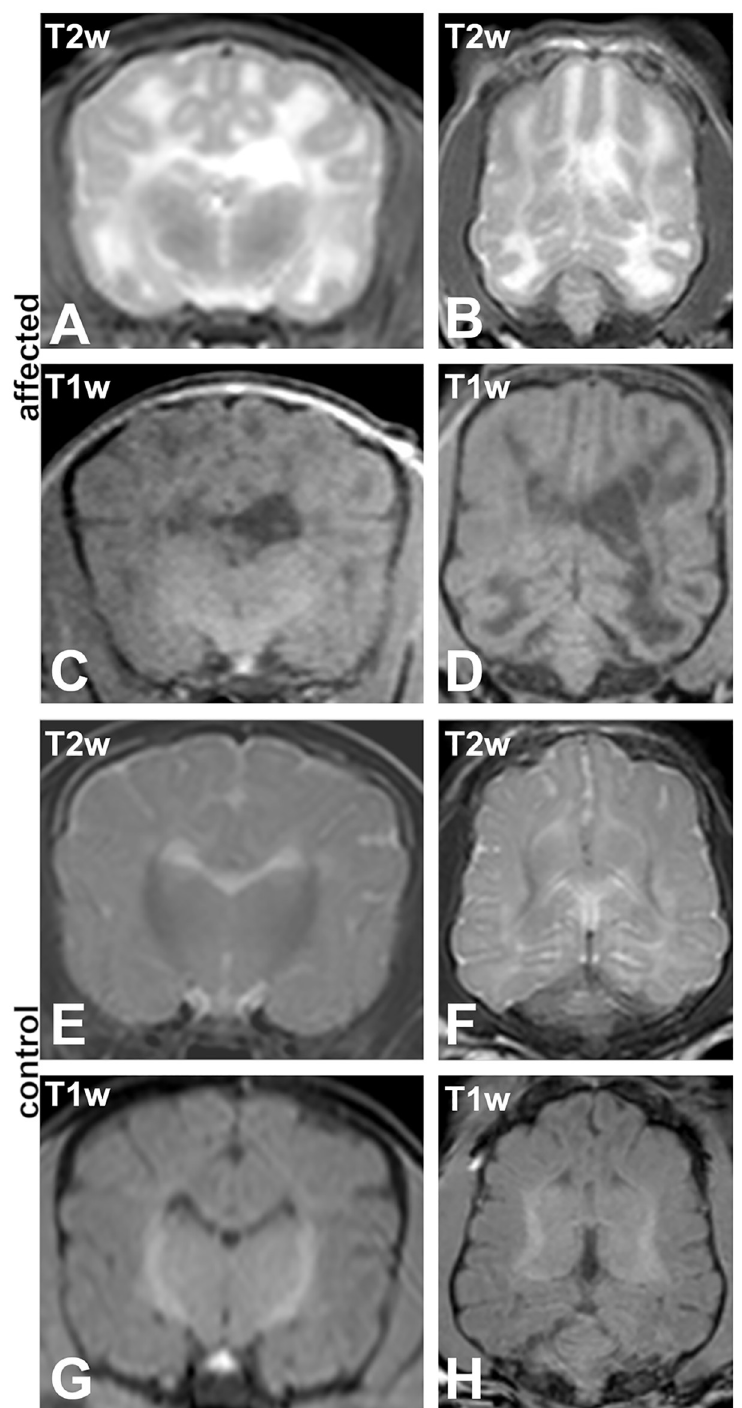
Fig 1. Magnetic resonance imaging (MRI). (A-D) Affected 4 weeks old Schnauzer puppy (no. 1) and (E-H) a clinically normal sibling at the same age (no. 14). (A, B, E, F) T2 weighted (T2w) sequences; (A, E) transversal and (B, F) dorsal. (C, D, G, H) T1 weighted (T1w) sequences; (C, G) transversal and (D, H) dorsal. MRI reveals mildly enlarged and asymmetric lateral ventricles and a T2w-hyperintense/T1w-hypointense lesion diffusely involving the whole cerebral white matter in affected animals. The age matched unaffected sibling shows beginning myelination in the central deep white matter, typical for the age.